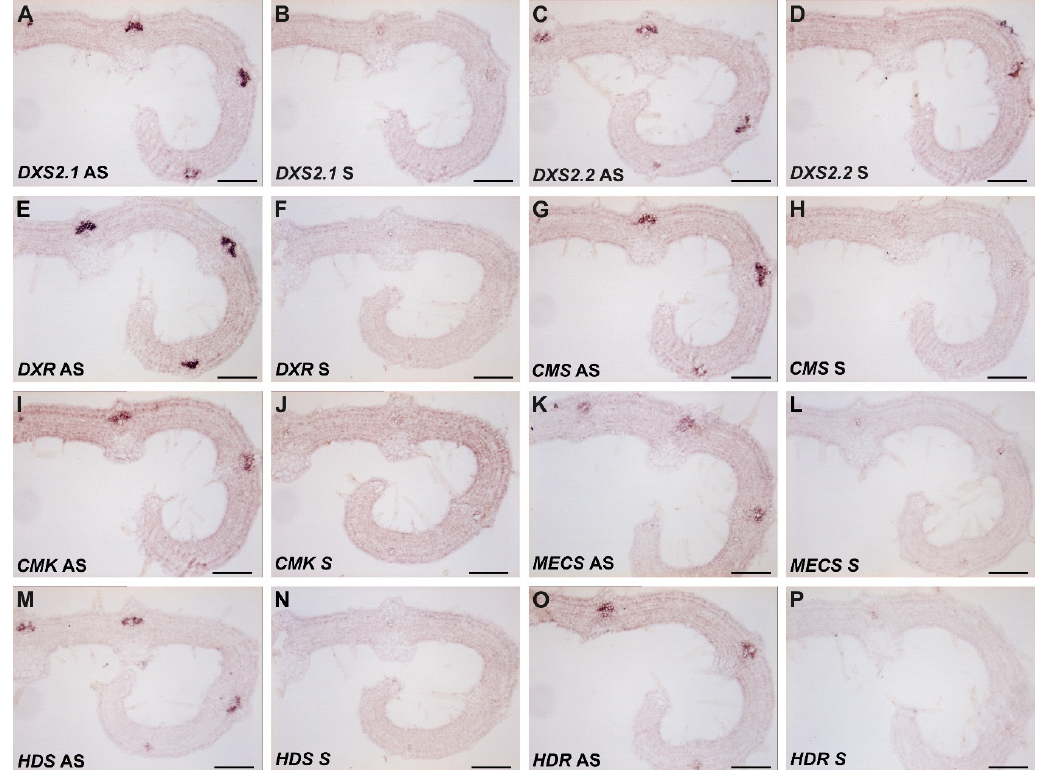
Figure 4. Coexpression of the MEP pathway genes in internal phloem associated parenchyma (IPAP) cells of C. roseus young leaves. Paraffin-embedded serial sections of young leaves were hybridized with digoxigenin-labeled transcripts, which were subsequently localized with anti-digoxigenin- alkaline phosphatase conjugates followed by nitro blue tetrazolium chloride (NBT)/5-bromo 4-chloro- 3-indolyl phosphate (BCIP) color development. The antisense (AS) probes used for RNA labeling and control hybridization with sense (S) RNA probes are mentioned in the figure. (A) DXS2.1 AS;